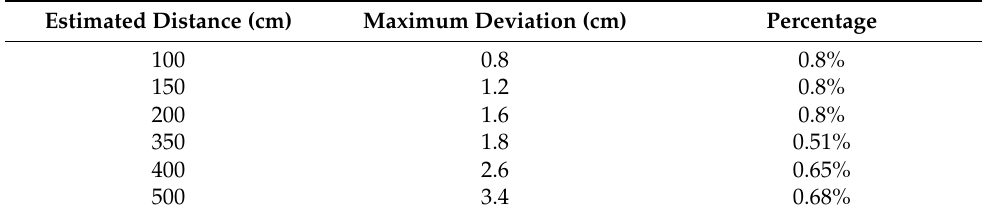
Table 2. Maximum deviation of the estimated